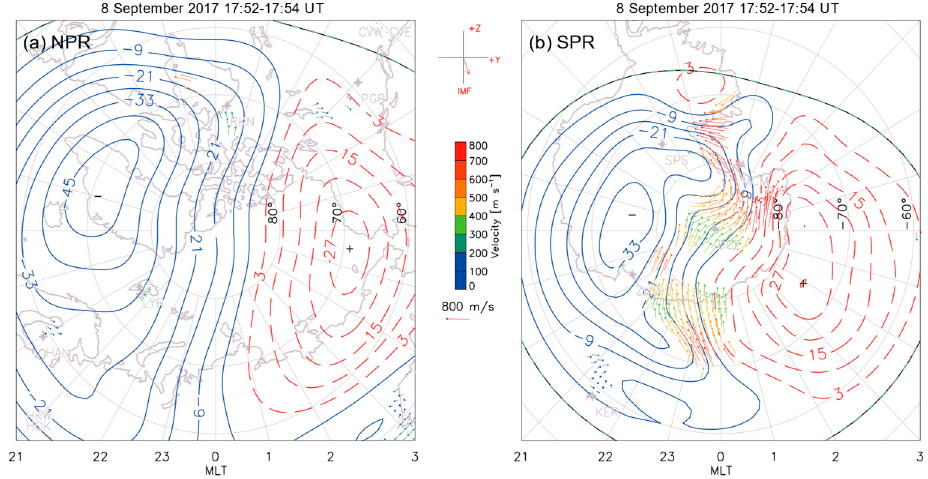
Figure 6. The two-minute SuperDARN convection pattern with E × B plasma flow pattern, charac- terized by colored vectors at individual grid measurement points and by equal potential lines (blue and red closed lines) plotted with 6 kV steps. ( a ): NPR; ( b ): SPR. IMF and flow velocity reference vector also marked in the fi gure.